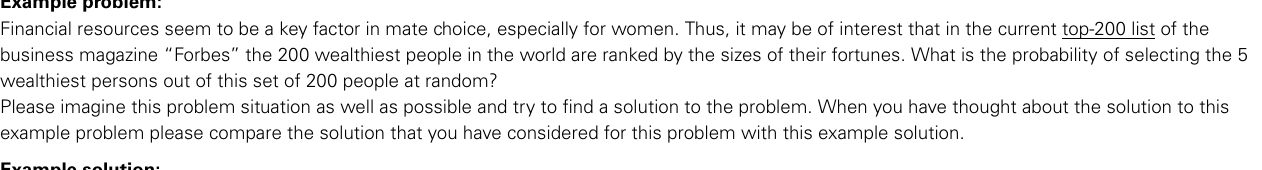
Table 1 | Test problems.